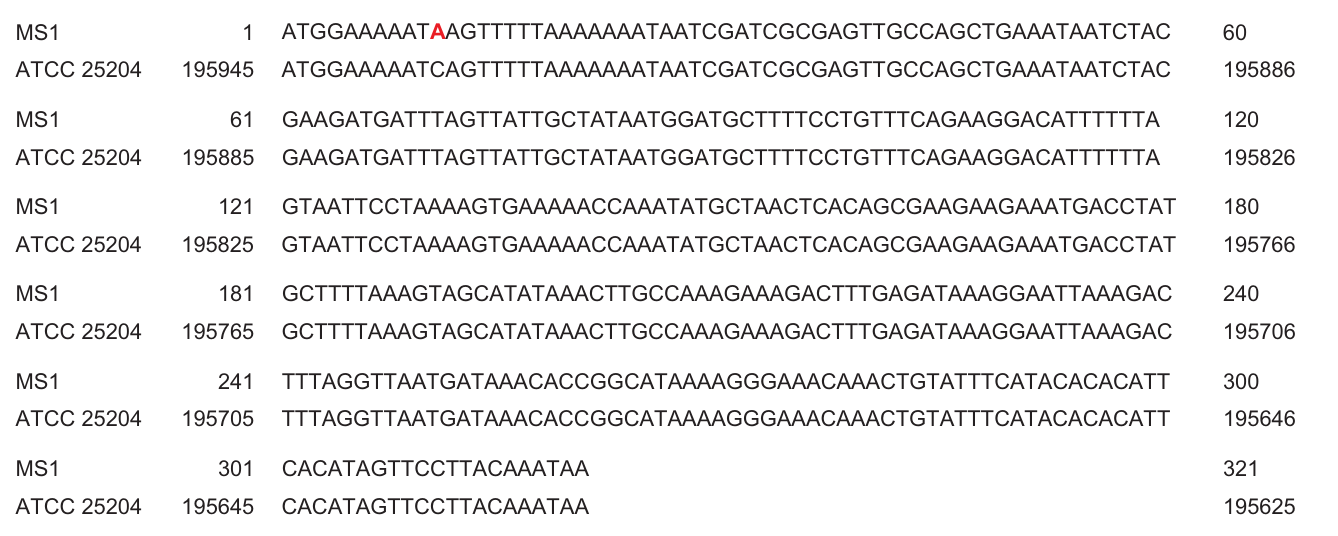
PLOS ONE | https://doi.org/10.1371/journal.pone.0175969 April 18,